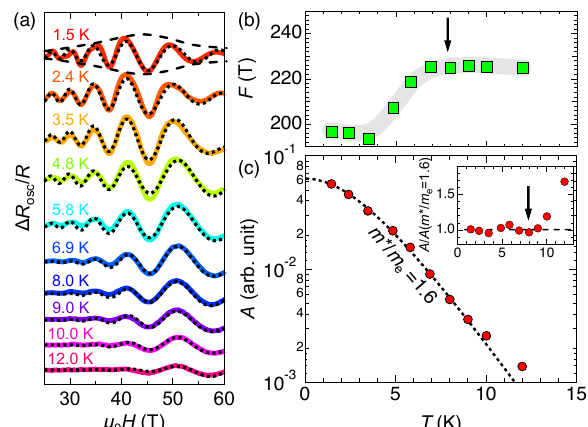
Figure 4. ( a ) Oscillatory component of the high-field magnetoresistance ∆ R osc / R [45]. The dotted curves are fits to the two-component LK formula. The dashed envelope is a visual guide for the amplitude of the oscillations. ( b , c ) Temperature variation in the frequency F ( b ) and the amplitude A ( c ) of one of the SdH signals. The dotted curve in ( c ) is a calculation obtained by the LK formula with m ∗ / m e = 1.6. The inset displays the ratio of A of the data and the simulation when m ∗ / m e =